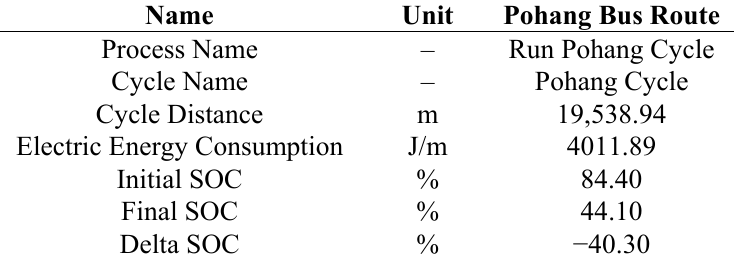
Figure 10. Experimentally measured SOC trace. Table 4. Summary of experimental results.